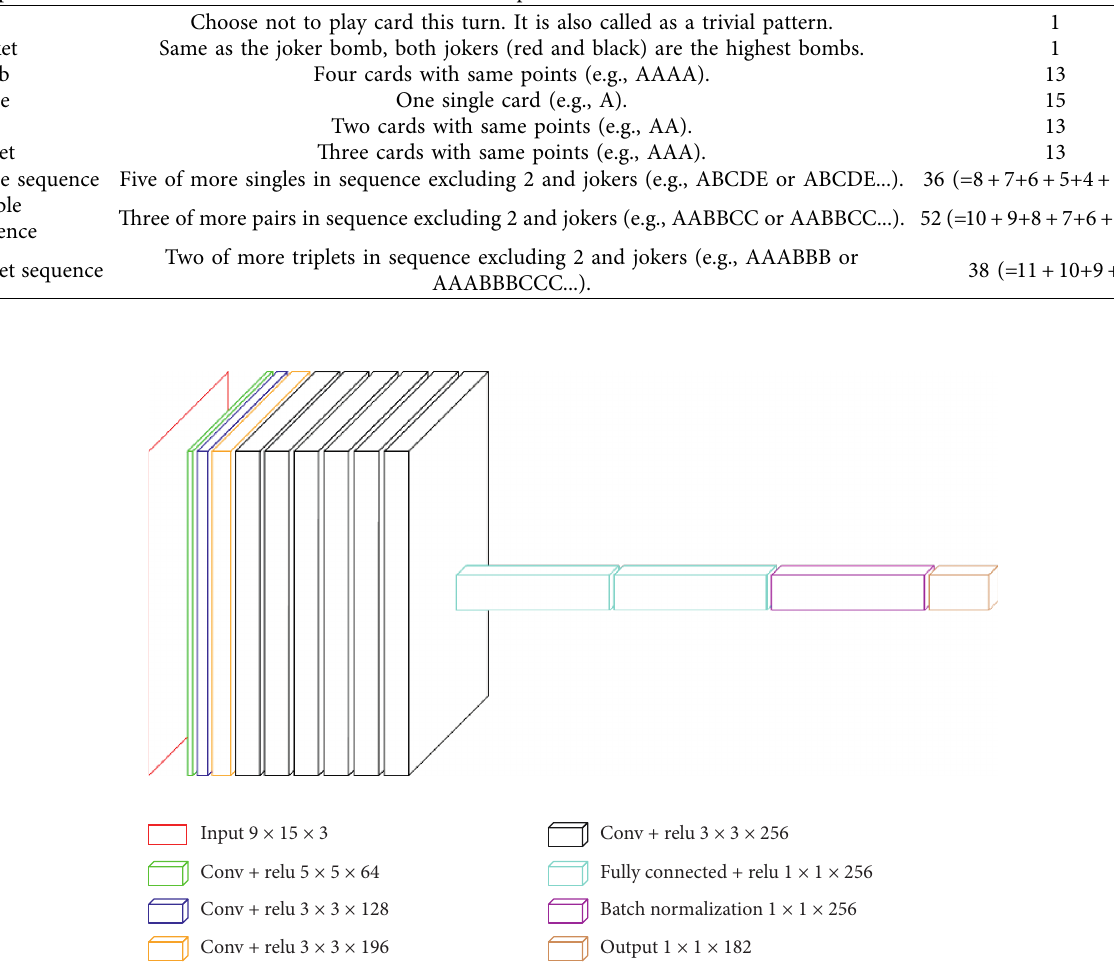
Figure 2: Role-based CNN network structure model.